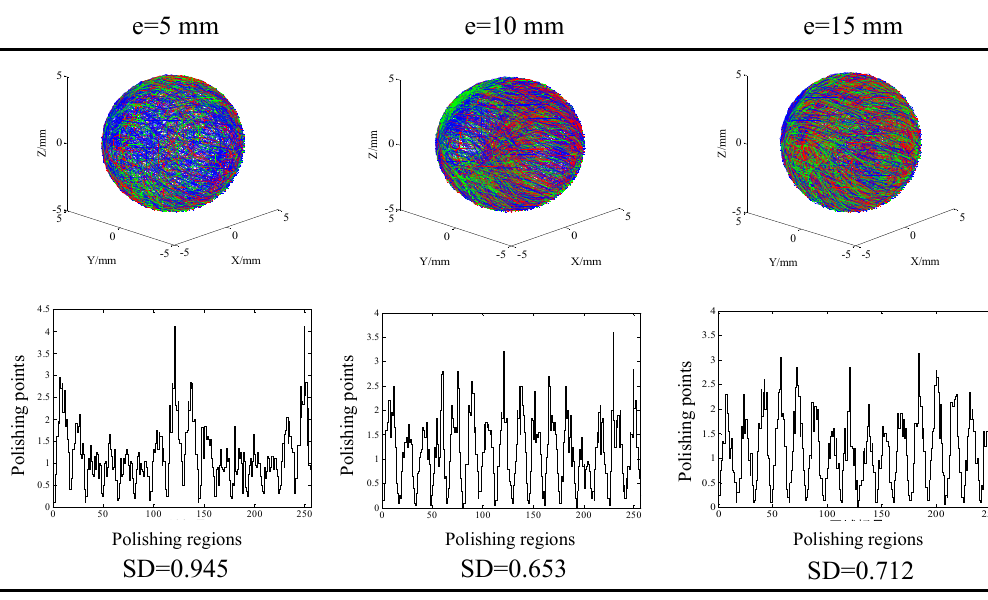
Figure 11. Distribution of the finishing traces at different eccentricities when the rotating ratio and machining gap were fixed ( δ = 0.8 mm, r = 3/4).